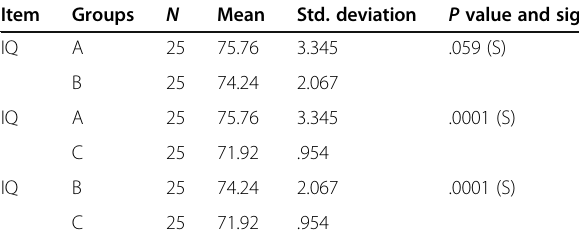
Table 2 IQ scores of the study